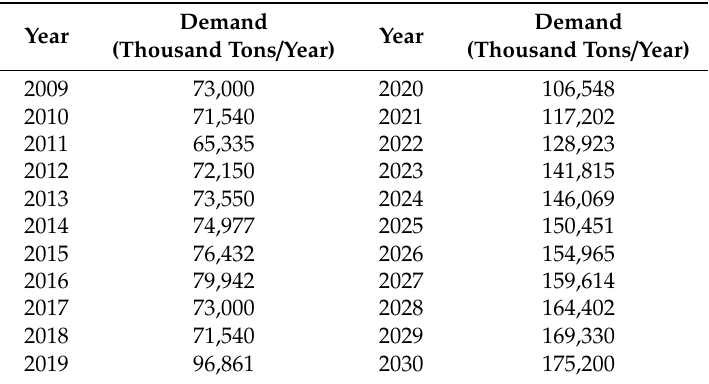
Table 4. Wastewater treatment demand in the Xin’an and Xixiang areas.